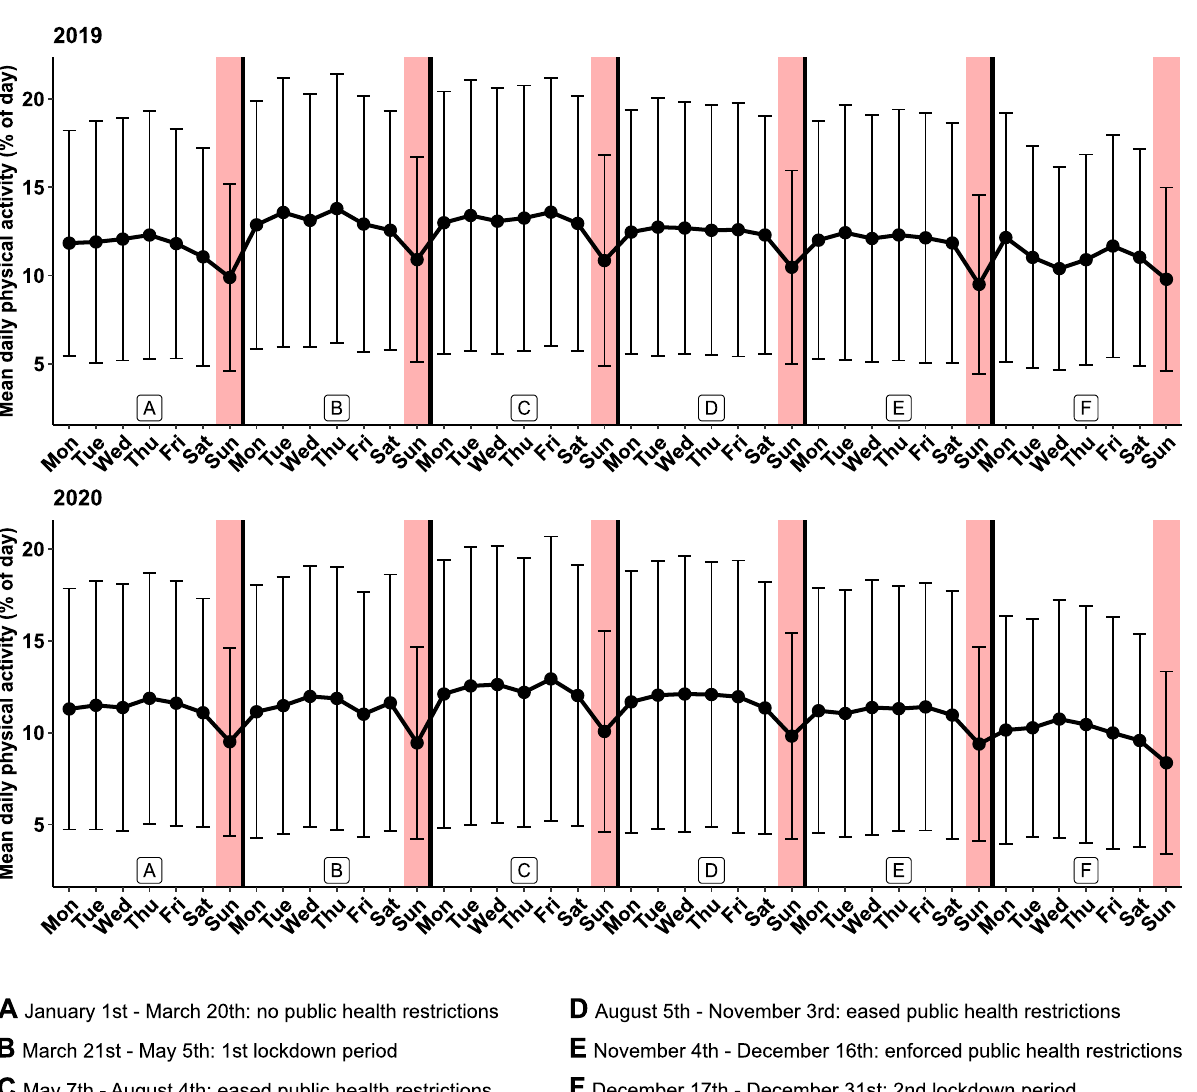
Fig 2. Display of mean daily physical activity (MDA) for each weekday in time intervals A to F in 2019 and 2020. Black dots reflect the arithmetic mean of MDA, calculated over all patients per respective weekday in one time interval. Intervals A to F in the years 2019 and 2020 are displayed. Whiskers show standard deviation (SD) of